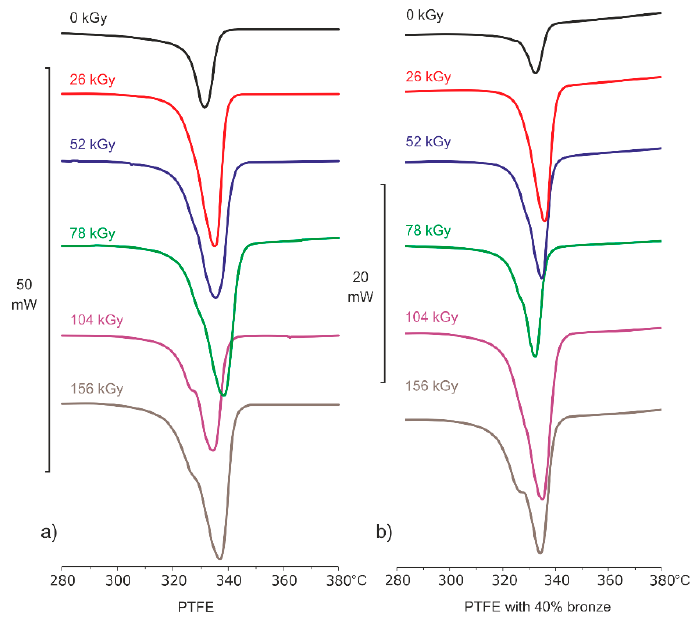
Figure 2. Differential scanning calorimetry (DSC) thermograms for ( a ) PTFE and ( b ) PTFE with 40% bronze in their initial states and after electron beam irradiation, registered during the heating process. Analysis of DSC thermograms registered during the melt recrystallization process (Tables 1 and 2 and Figure 3) allowed the determination of T c and ∆ H c .